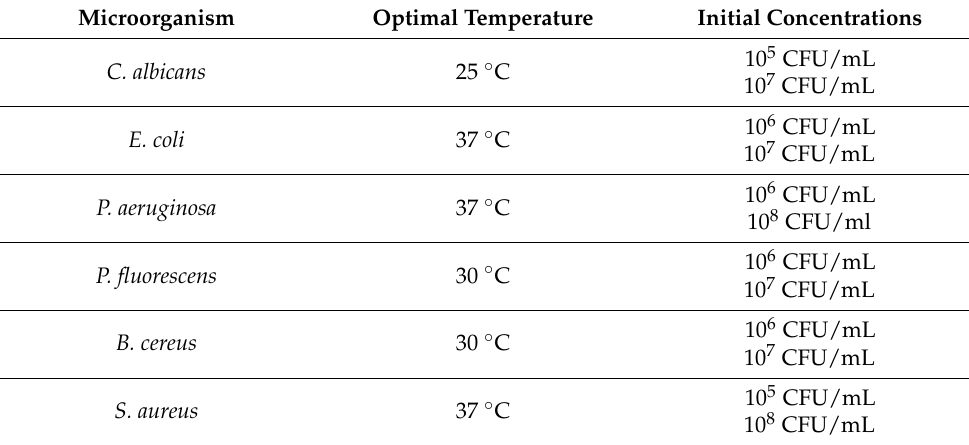
Table 4. Optimal conditions and initial concentrations of microorganisms for qualitative determina- tion of antimicrobial activity.